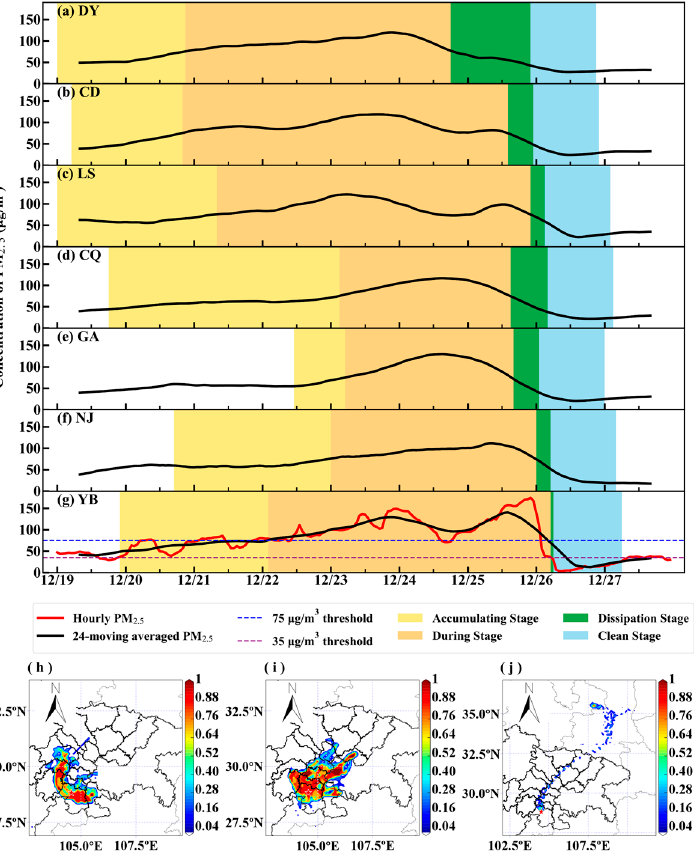
Figure 10. The evolution of PM 2.5 concentrations in ( a ) Deyang, ( b ) Chengdu, ( c ) Leshan, ( d ) DCQ, ( e ) Guang’an, ( f ) Neijiang, and ( g ) Yibin, and the PSCF results of Yibin in the ( h ) accumulating stage, ( i ) during stage, and ( j ) clean stage.